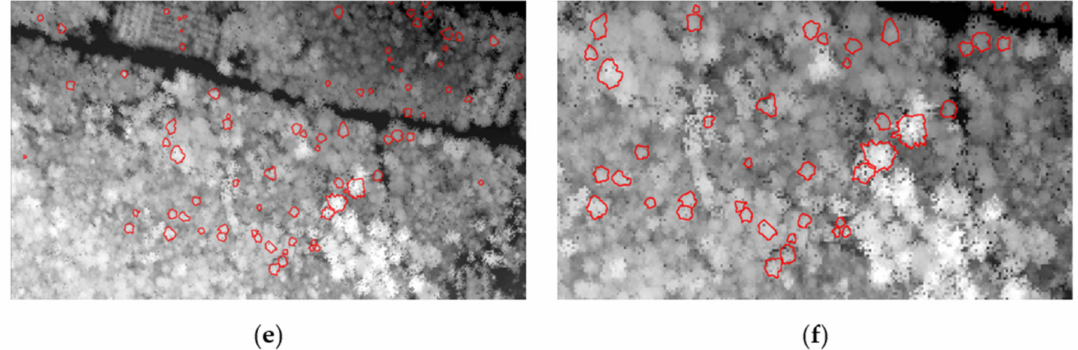
Figure 3. Individual tree crown alignment comparisons for the three datasets: ALS12 ( a , b ); MSL16 ( c , d ); SPL18 ( e , f ). The crown polygons in red are crowns that were delineated on the ALS12 dataset ( a , b ), field identified and carried forward for training on the other two datasets. The crowns still align well visually with the respective CHMs.